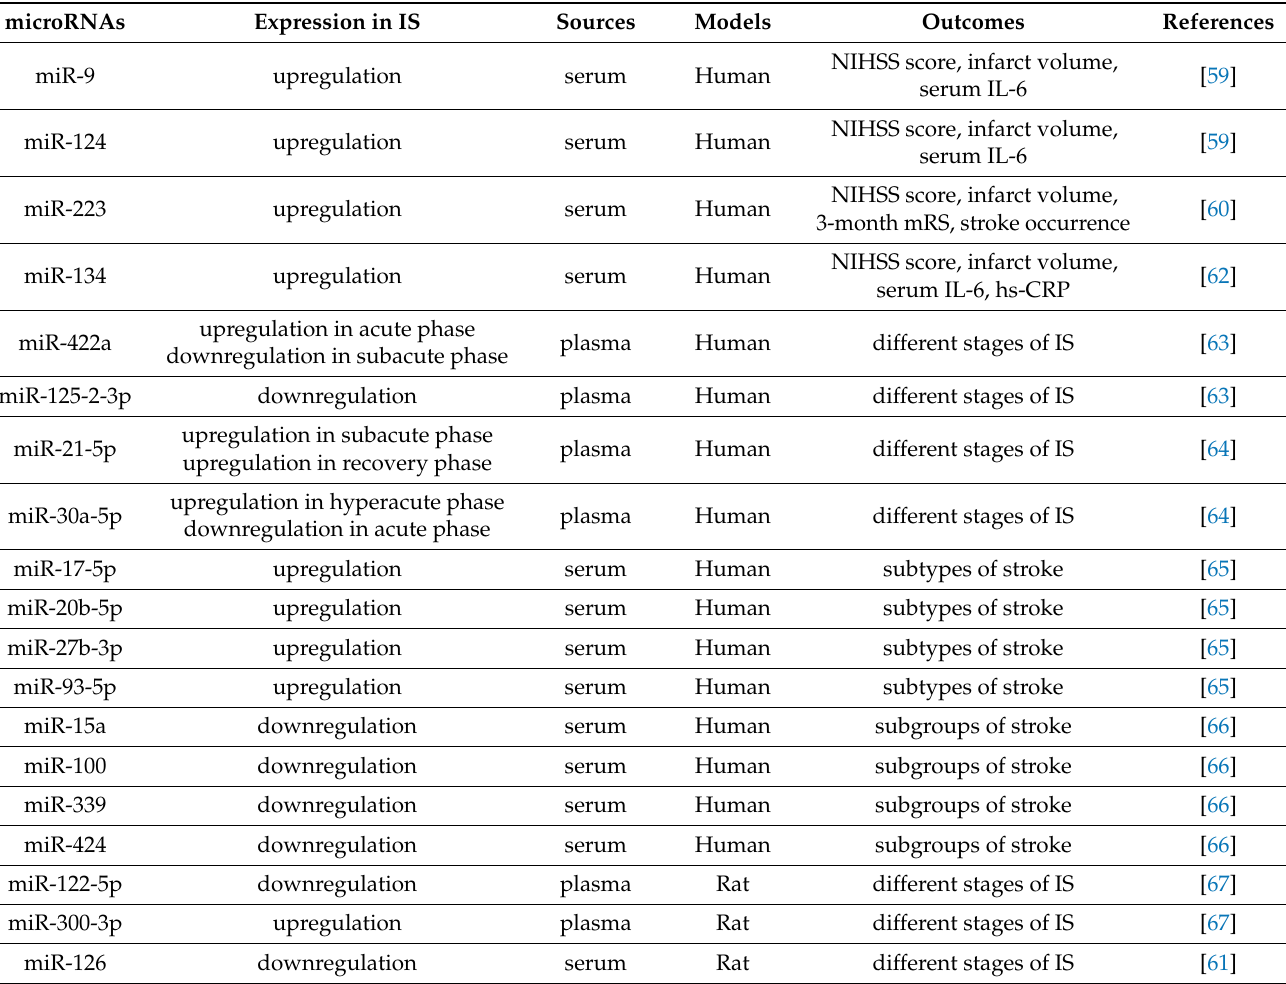
Table 1. Exosomal microRNAs as Biomarkers in the Diagnosis of Ischemic